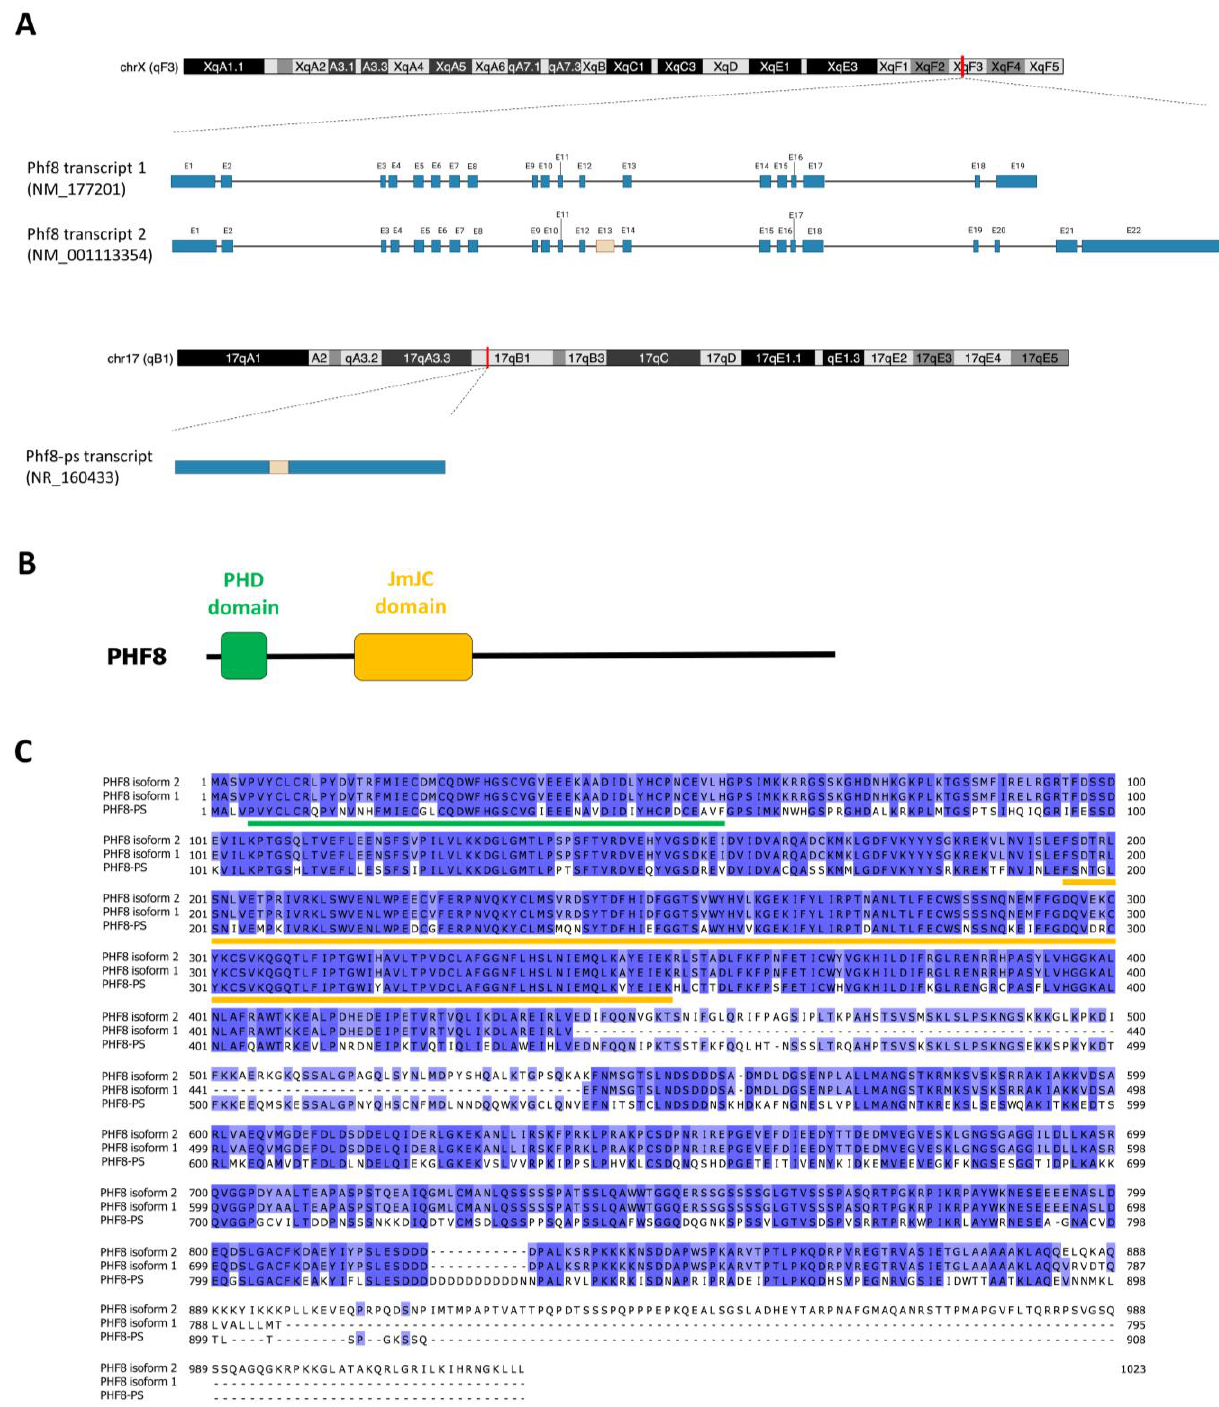
Figure 1. Characteristics of the mouse Phf8 and Phf8-ps genes. (A) Schematic depicting the chromosomic location of Phf8 and Phf8-ps genes in the mouse genome, and the respective transcripts produced by these genes. Exons are represented in blue boxes (excepted alternative exon 13 in beige) and introns by a line (image created with Biorender.com). (B) Schematic diagram of PHF8 protein structure with the functional PHD and JmjC domains. (C) Alignment of protein sequences of PHF8-PS and PHF8 isoforms. Sequences were obtained from the NCBI Ref seq database. Sequence alignments were performed using Jalview (version 2.11.2.3) and the Clustal Omega algorithm with default parameters. The conserved PHD and JmjC domains are respectively underlined in green and orange.